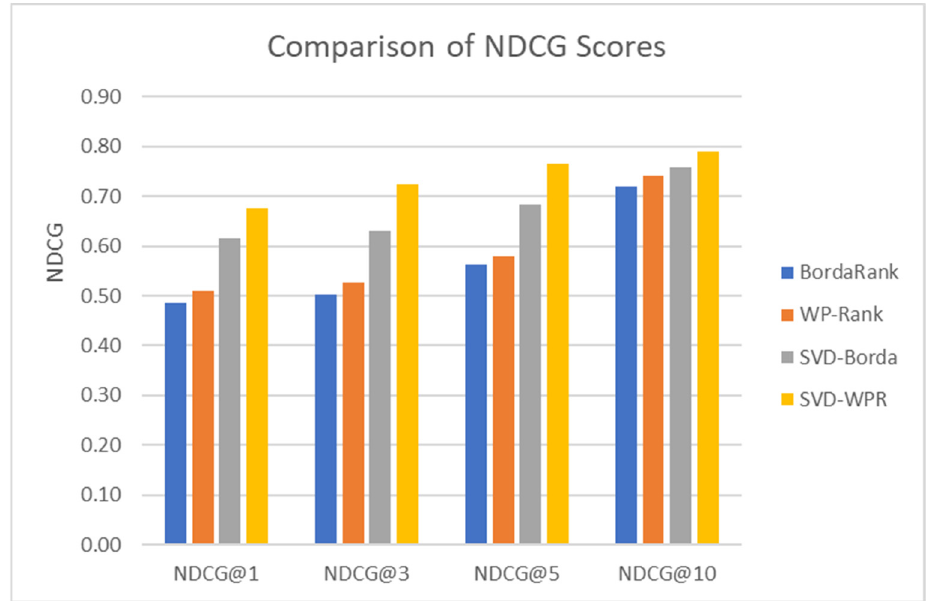
Figure 4. Comparison of NDCG scores of each algorithm on the MovieLens 100K dataset.